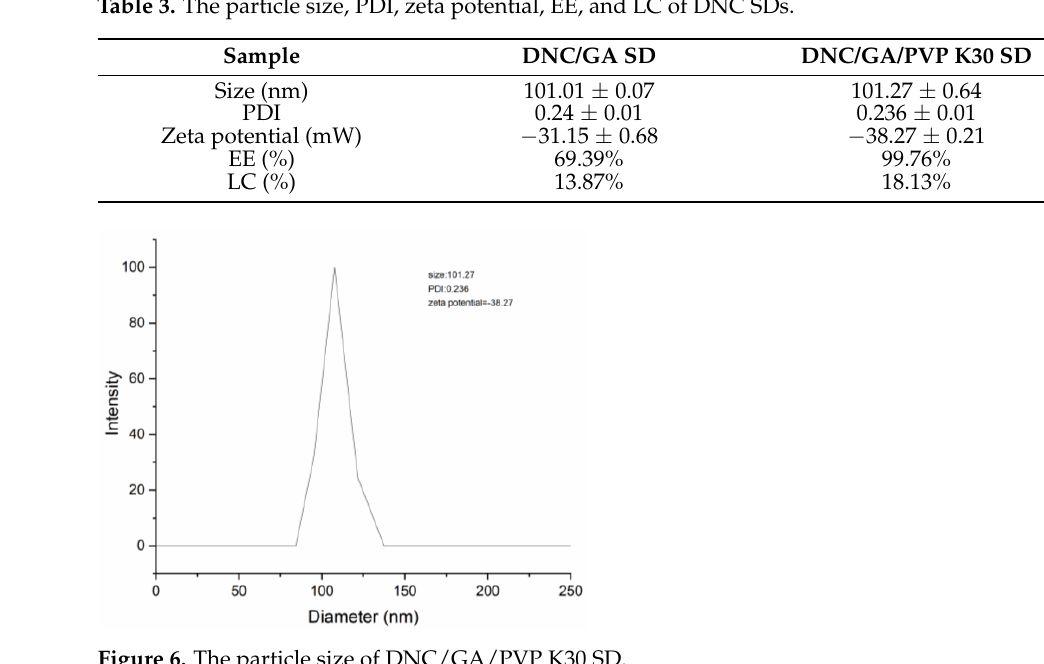
Figure 7. TEM image of DNC/GA/PVP K30 micelles .